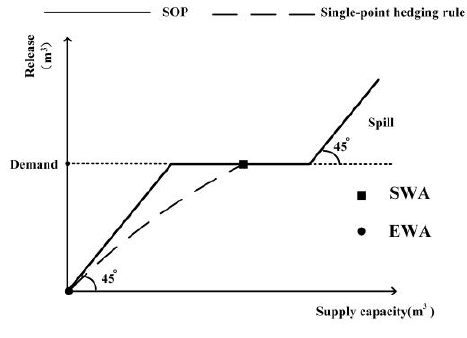
Figure 2. Scheme of one-point hedging rule.